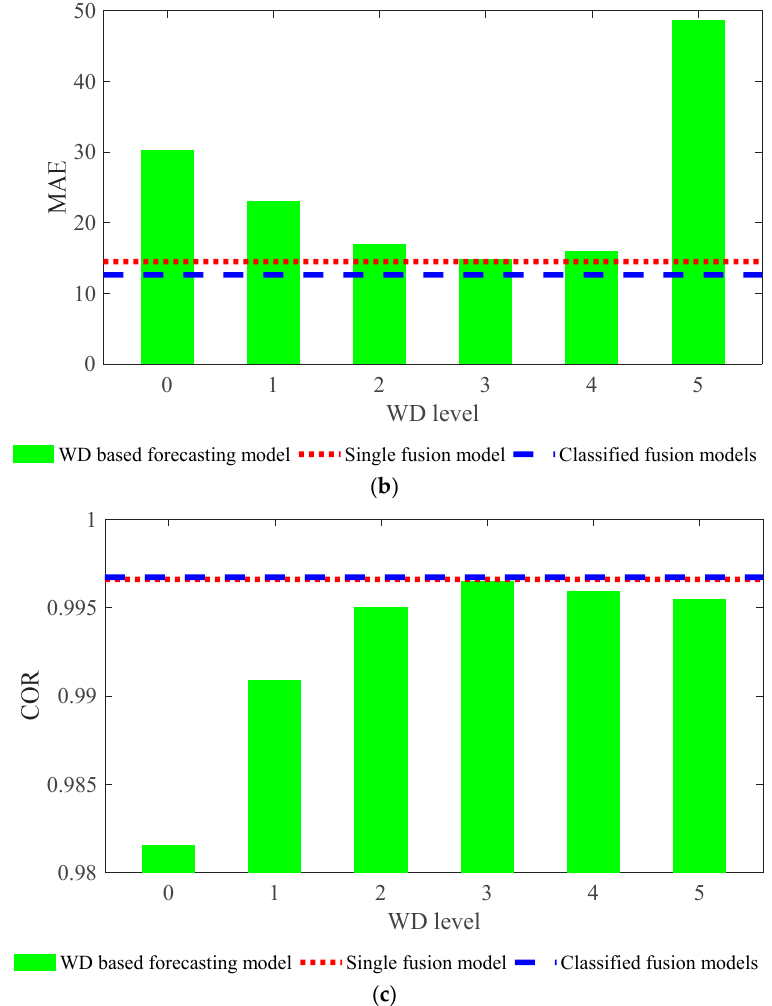
Figure 10. The accuracy of different forecasting models at Desert Rock station. ( a ) The Root Mean Squared Error (RMSE) of forecasting results; ( b ) The Mean Absolute Error (MAE) of forecasting results; and, ( c ) The Correlation Coefficient (COR) of forecasting results.